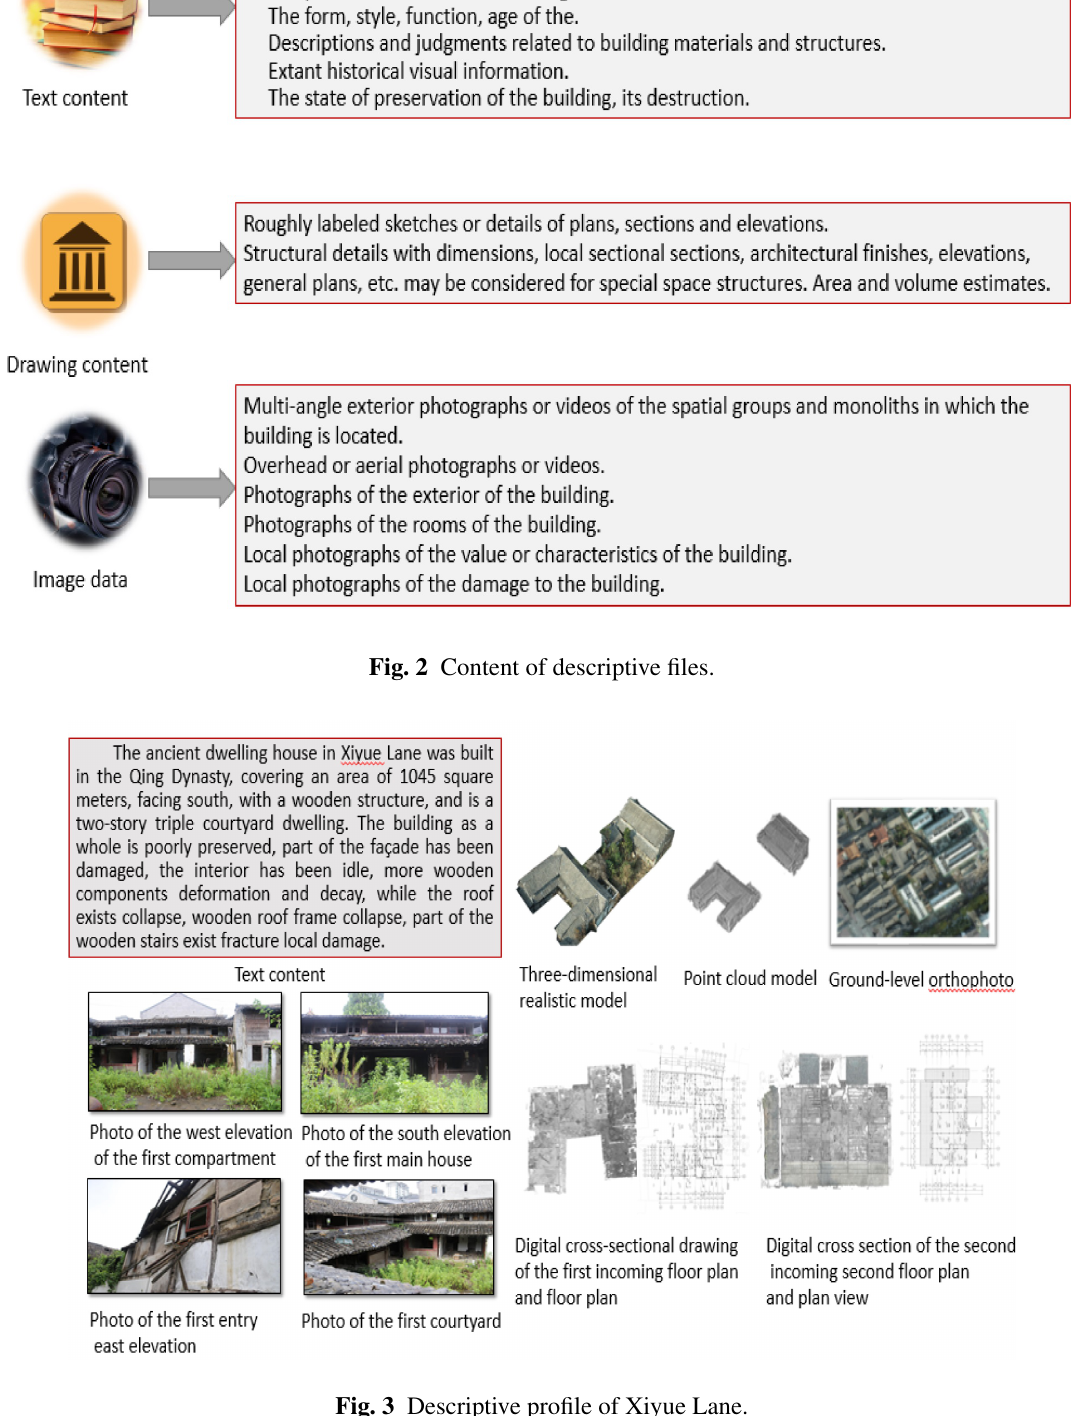
Fig. 3 Descriptive profile of Xiyue